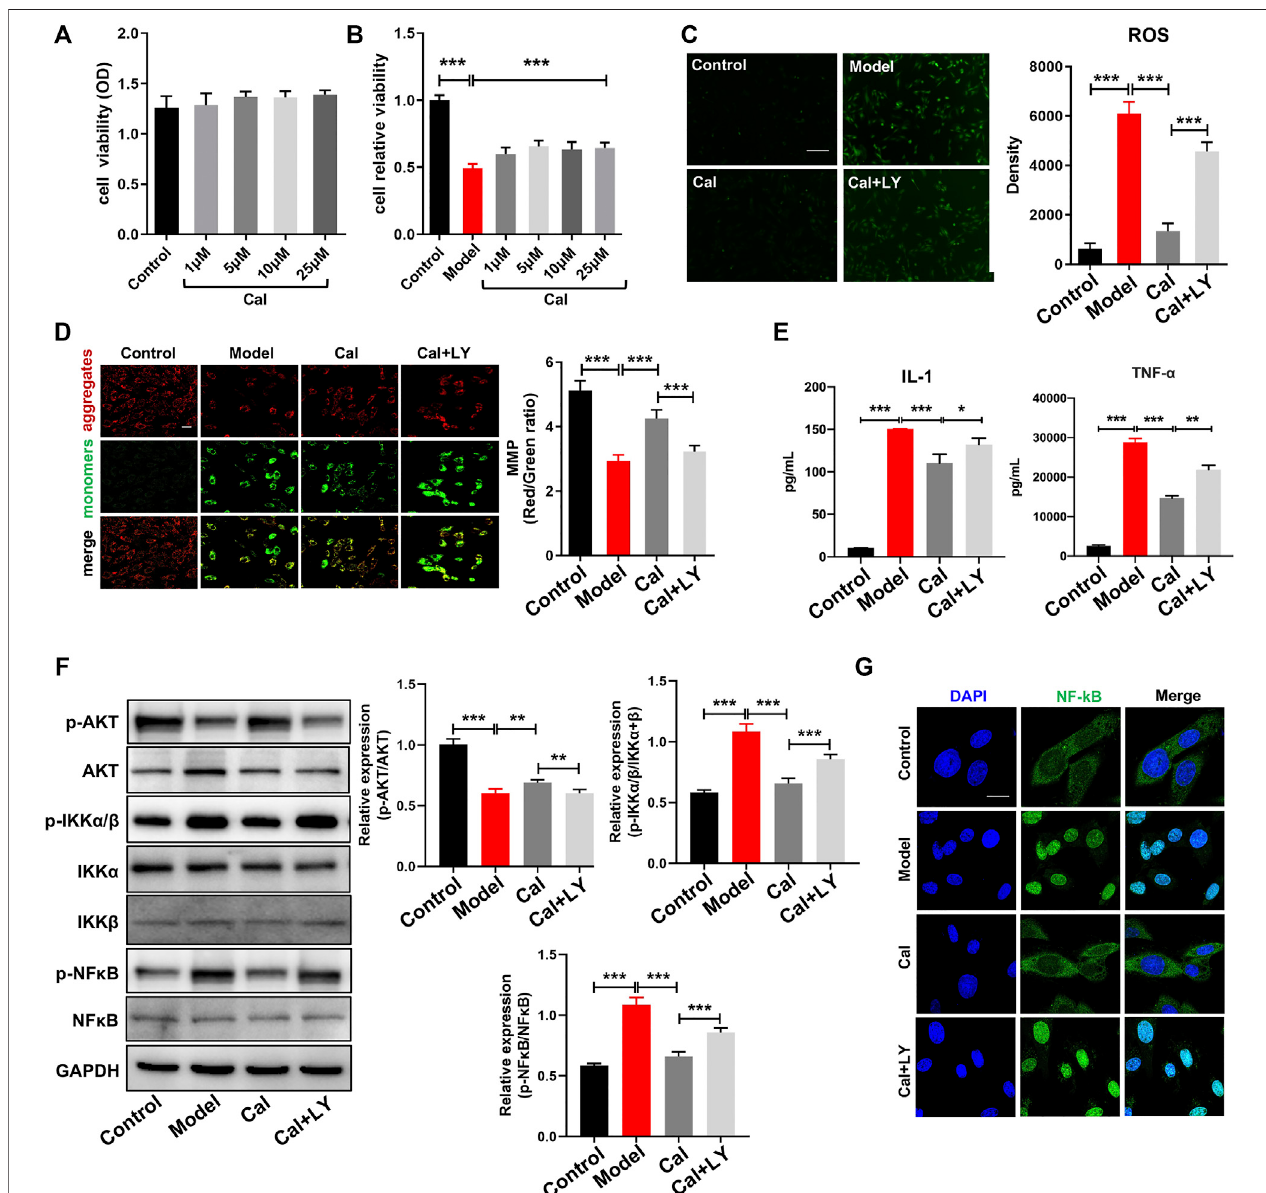
FIGURE 5 | Anti-in fl ammation effects of Cal via the PI3K – AKT signaling pathway in cardiomyocytes. CCK8 assay was used to determine cell injury. (A) Cal (1 – 25 μ M)hasnocytotoxicityonH9C2cellscomparedwiththecontrolgroup. (B) Conditionedmedia(CM)-inducedcellularinjuryinH9C2cellsandCal(5 μ M)increased cellviabilitysigni fi cantly. (C) reactiveoxygenspecies(ROS)staininginthedifferentgroups, N = 12.(D)Mitochondrialmembranepotential(MMP)wasdeterminedbyJC-1 probe (400×, scale bar = 100 μ m), N = 12. (E) The release of IL-1 and TNF- α in H9C2 cell supernatants was detected by ELISA assay, N = 12. (F) Western blot bandsof p -AKT, p -IKK α / β ,and p -NF κ Bandquantitativeresultsincells. (G) Immuno fl uorescencestainingofNF κ Bunderdifferenttreatments;scalebar = 50 μ m. N = 20 cells per group. Data are presented as the mean ± standard error of three independent experiments. * p < 0.05, ** p < 0.01, *** p < 0.001.